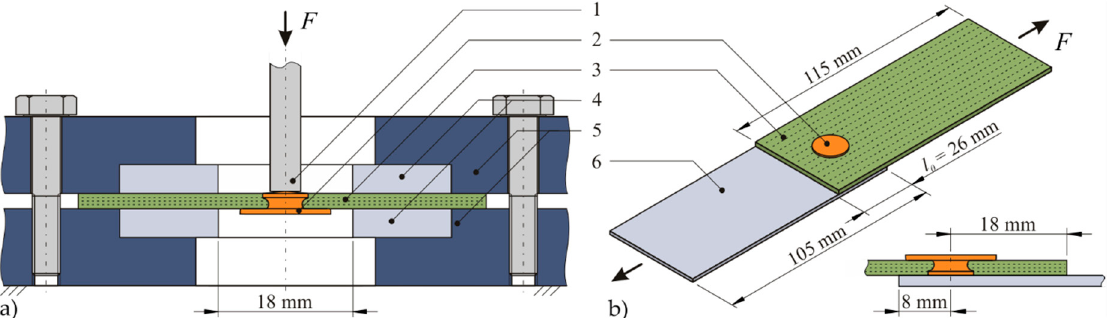
Figure 5. ( a ) Schematic illustration of the push-out test setup, ( b ) geometry of single-lap shear specimen ( l o : overlap length); 1: pressure punch, 2: weld insert, 3: TPC specimen, 4: exchangeable steel clamping, 5: base steel plates, 6: steel specimen.